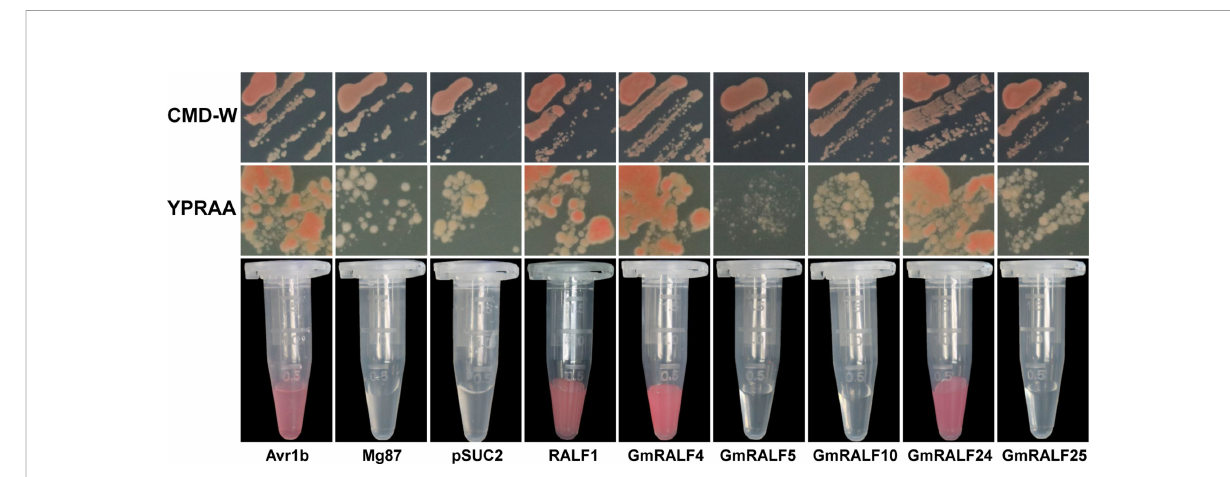
FIGURE 7 Analysis of the secretory function of selected GmRALF members. The yeast YTK12 strain carrying GmRALF4 and GmRALF24 signal peptides fragment fused in the pSUC2 vector were able to grow in both the CMD-W and YPRAA media, and also induce a red color reaction, indicating the secretory function. Others contained no secretory function. Avr1b was a secreted protein and served as a positive control in this study. Mg87, a Magnaporthe oryzae protein, was shown to have no secretory function in 2011 and was here used as a negative